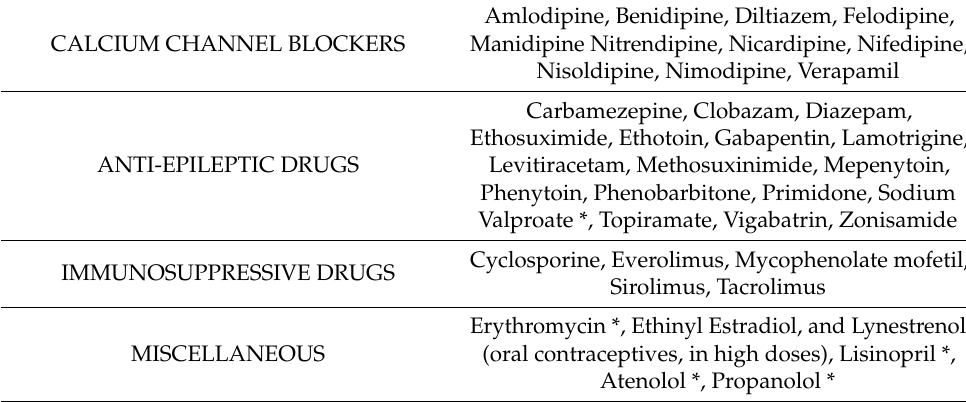
Table 1. Drugs that are documented to cause Gingival